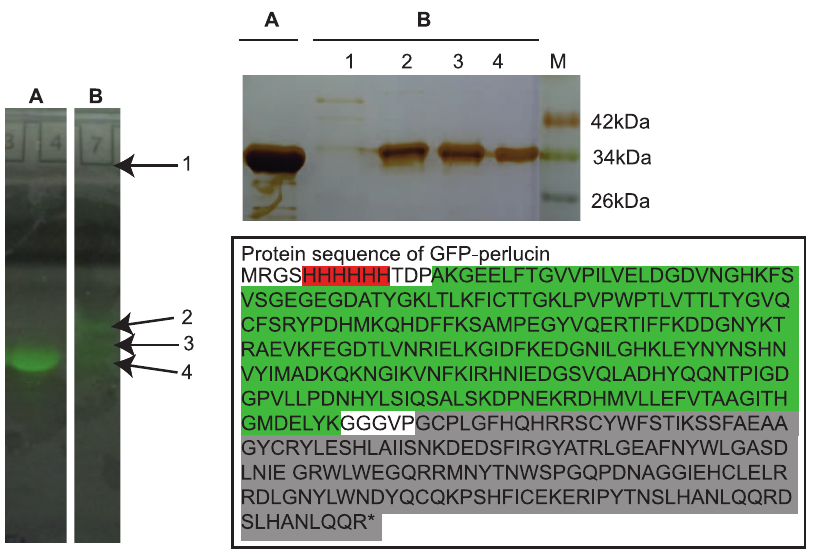
Figure 5. Native PAGE of GFP (28.9 kDa), GFP-perlucin (46.8 kDa), and SDS-PAGE analysis of extracted GFP-perlucin derivatives. Purified GFP yielded one distinct band (A). Affinity-purified GFP-perlucin (B) migrates in 3 separate fluorescent bands (2–4) in native PAGE and another fluorescent species remains in the well (1). The latter contains the full-length GFP-perlucin (46.8 kDa) as demonstrated by denaturing SDS- PAGE under reducing conditions and silver staining (bottom right, amino acid sequence of perlucin (grey) with affinity tag (red) and GFP (green)). Bands 2–4 were identified as truncated versions of the recombinant protein (29.8–30.3 kDa) by MALDI-TOF/TOF (Figure 3). Molecular weight marker (M).